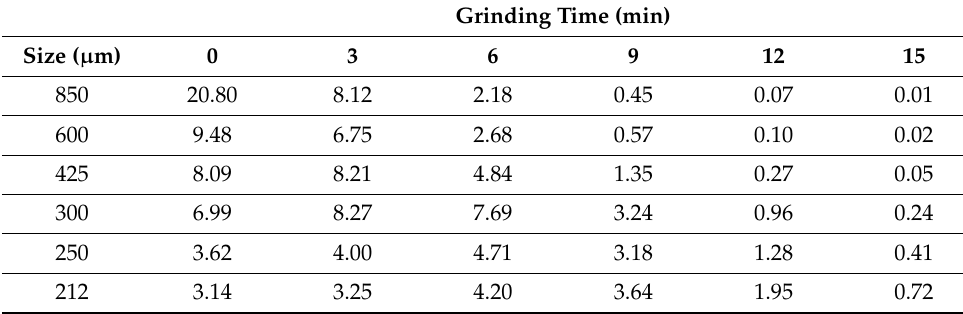
Table A2. Experimental data for the weight of each sizer (%) for LGP-1 ore-B. Grinding Time